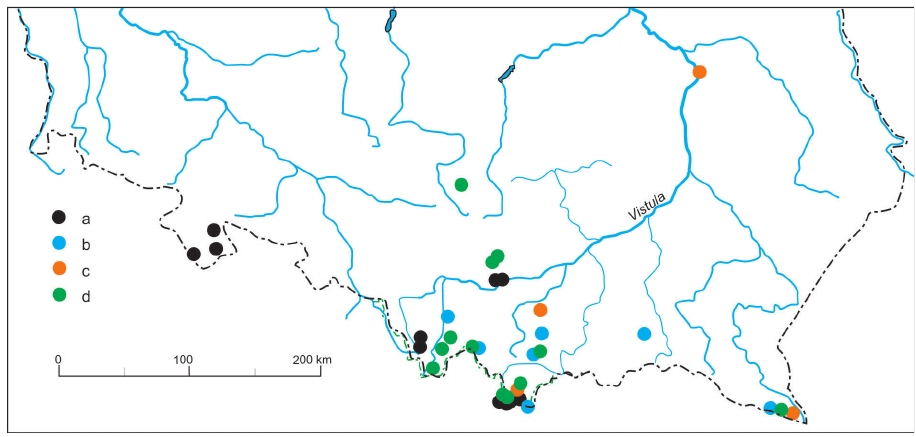
Figure 4. Distribution of Niphargus tatrensis in various habitats in Poland; a caves b surface waters c wells d